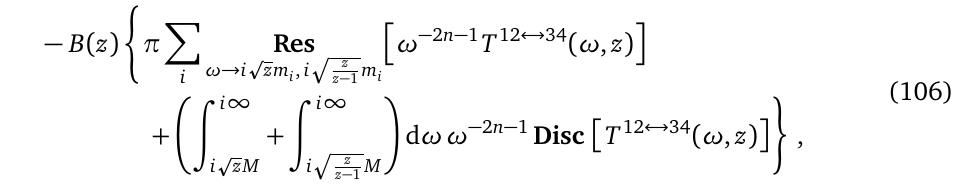
to C (cid:48) 0 0